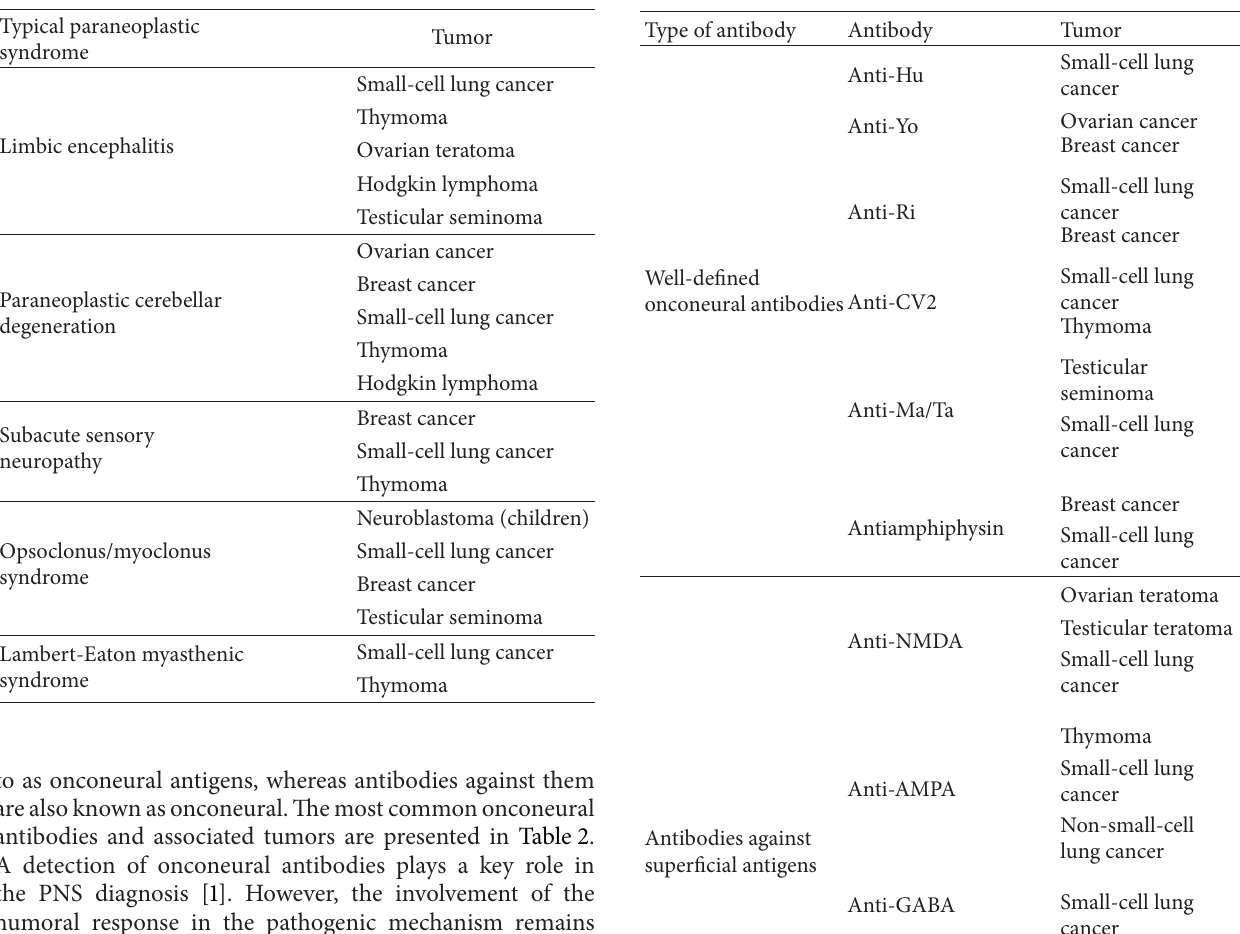
Table 1: The most common paraneoplastic neurological syndromes and associated tumors [1, 17, 100].